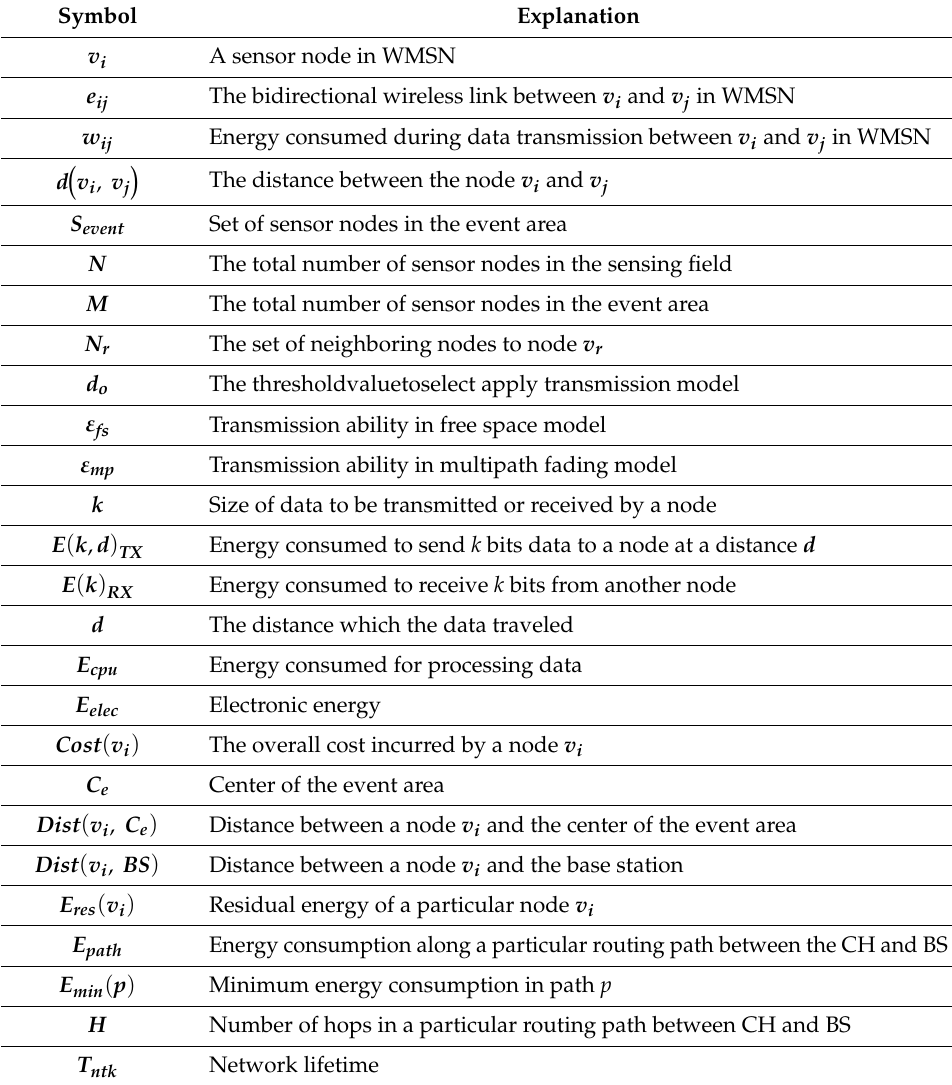
Table 1. The symbols and